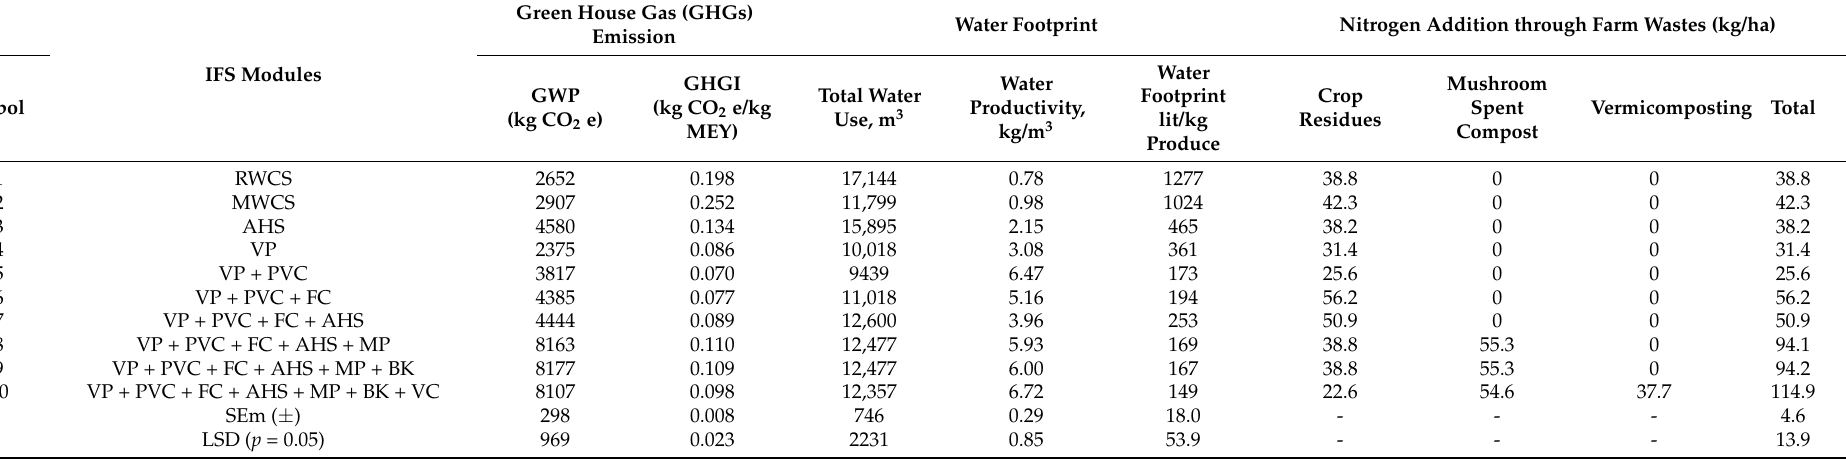
Table 9. Greenhouse gas emission, water footprints, and nitrogen addition through farm wastes under diverse modules of the integrated farming